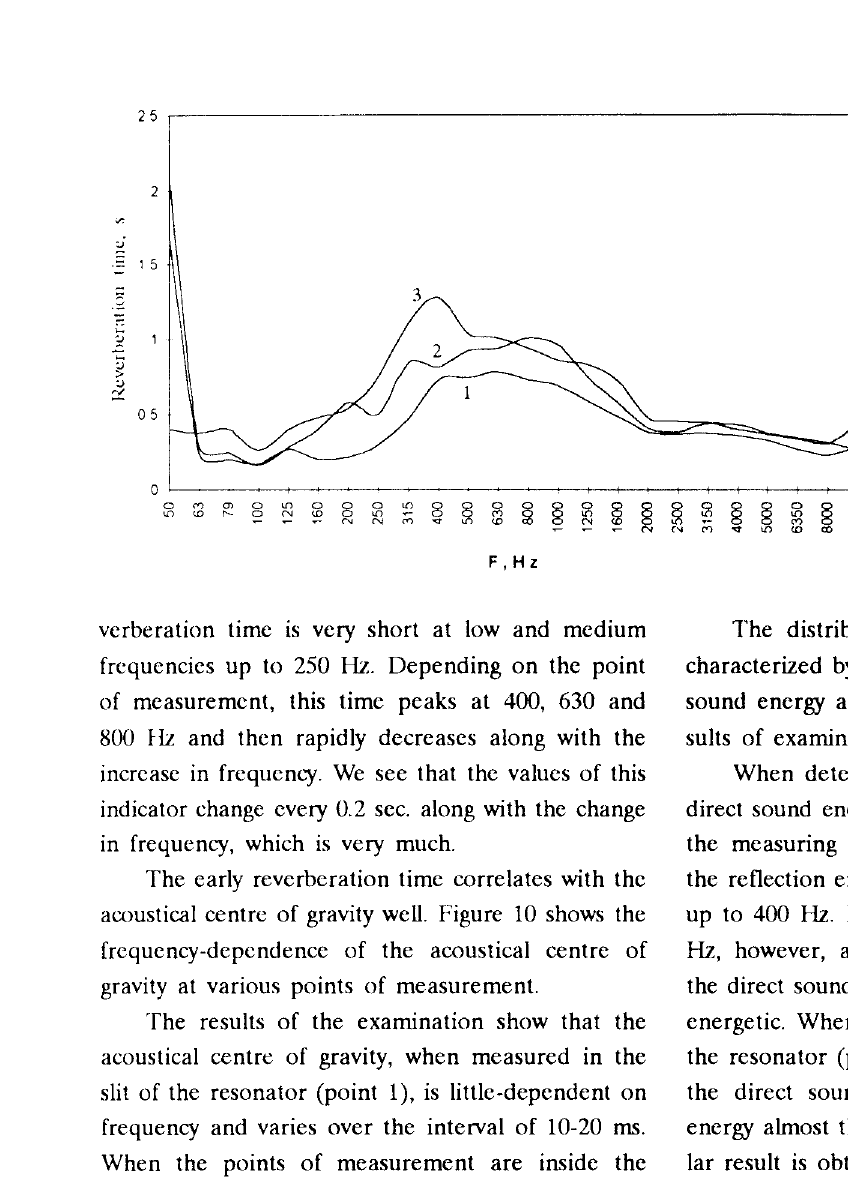
Fig. 8. The frequency-dependence of the reverberation time of an iso lated resonator with a cross-shaped slit at 0-30 dB. I, 2, 3 - measure ment points